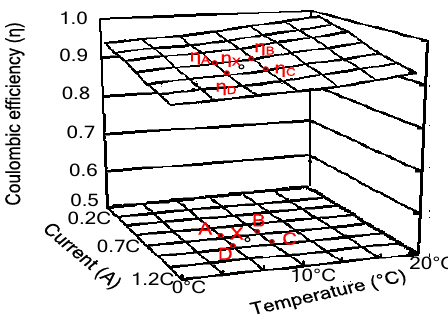
Figure 5. The Coulombic efficiencies of critical and non-critical